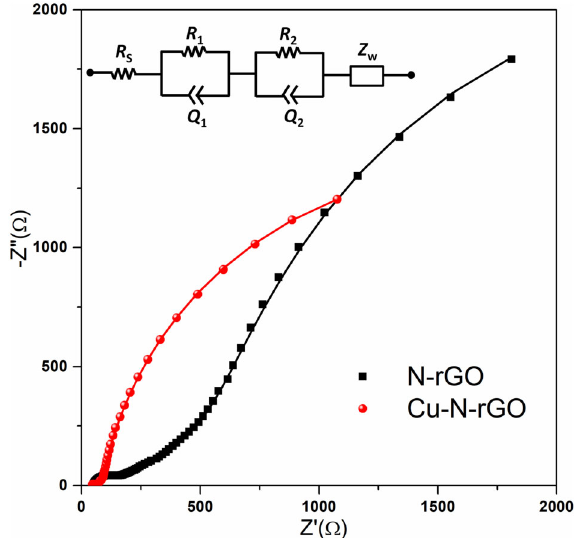
Fig. 8 Electrochemical impedance spectroscopy analysis. Electro- chemical impedance spectroscopy measurements on graphene- based catalysts in air-saturated 0.1 M KOH solution. The points are experimental data, the continuous lines are the curves simulated exploiting the equivalent circuit shown in the inset.